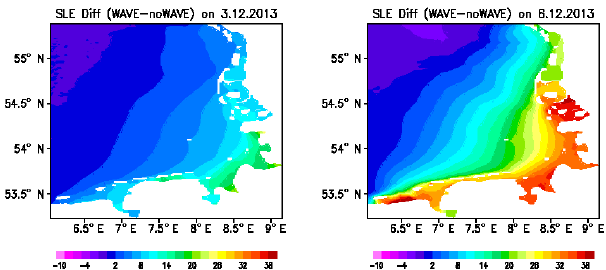
Figure 6. Sea level elevation (SLE) difference (cm) between the coupled wave–circulation model (WAM–GETM) and circulation- only model (GETM) for the German Bight on 3 December 2013 at 01:00UTC (left) and during the storm Xavier on 6 December 2013 at